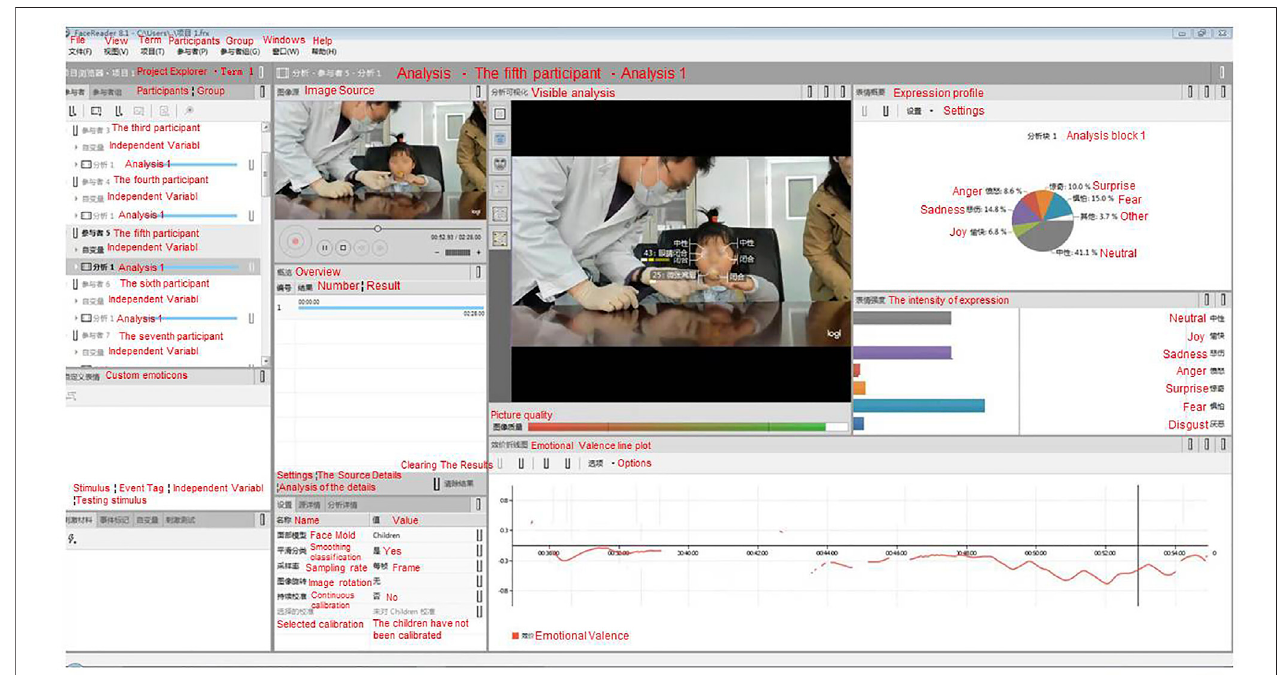
FIGURE 1 | Example of the facial action coding system FaceReader ™ (English translated from Chinese version) in this study that uses facial expression collection.